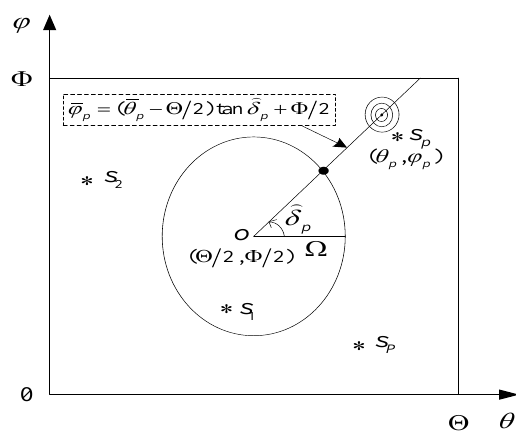
s 1 and * s 2 represent signals 1 and s and * s represent signals 1 and 2. Figure 3. Proposed search scheme. * 1 2